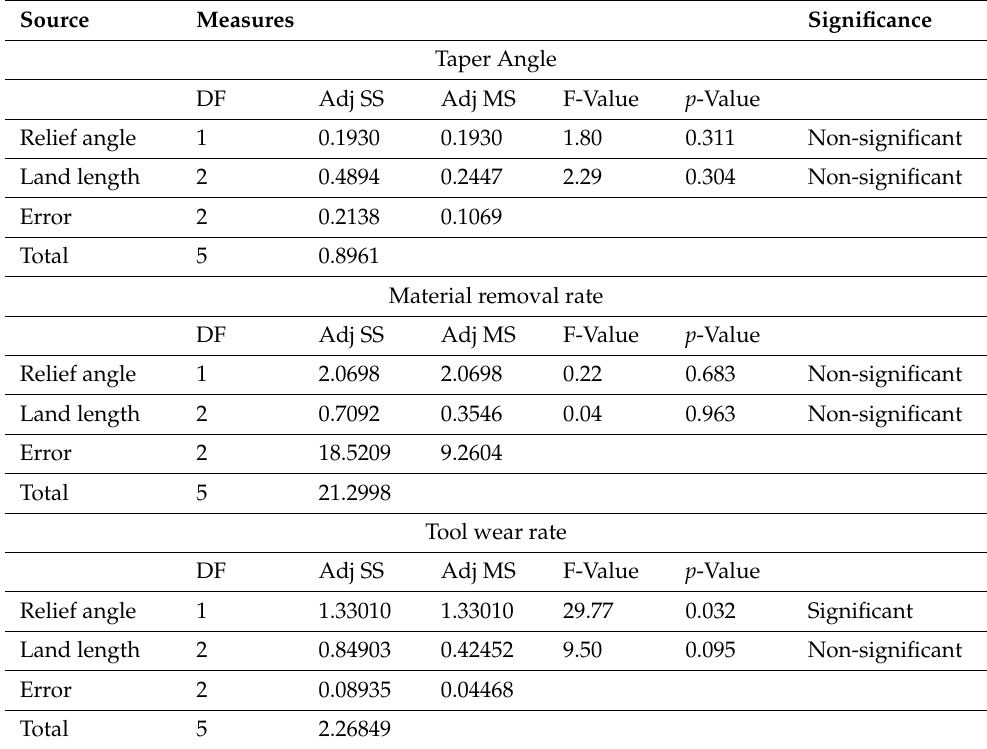
Table 7. Analysis of variance for machining